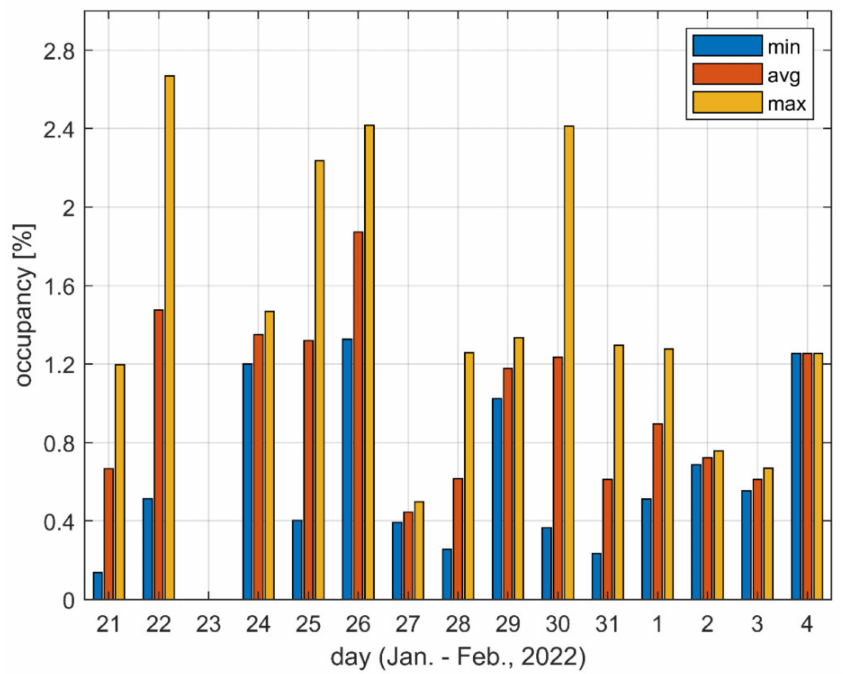
Figure 5. Minimum, average and maximum observed channel occupancy values for Location A.